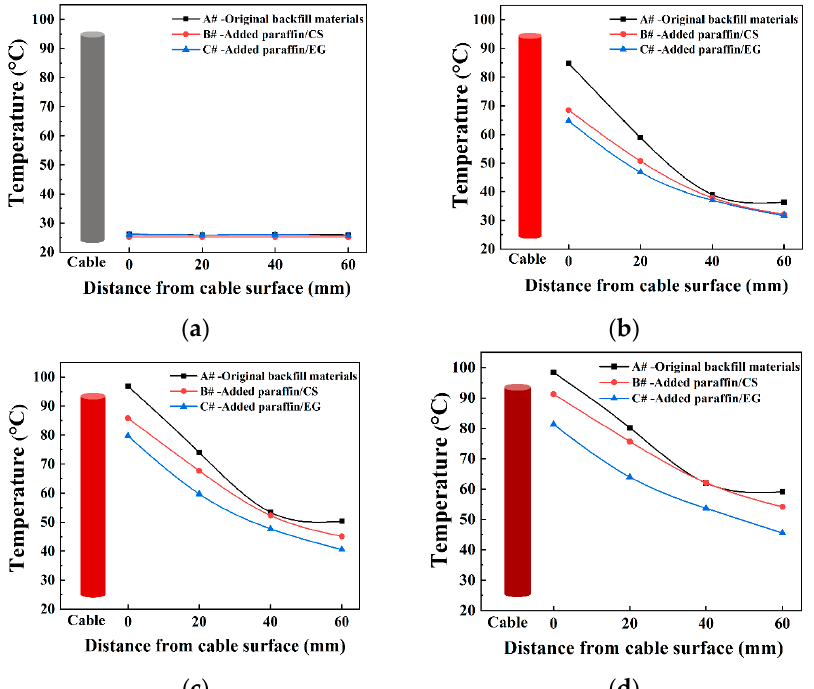
Figure 8. Temperature variations of the samples during different heating periods: ( a ) T = 0 h; ( b ) T = 2 h; ( c ) T = 4 h; ( d ) T = 6 h.